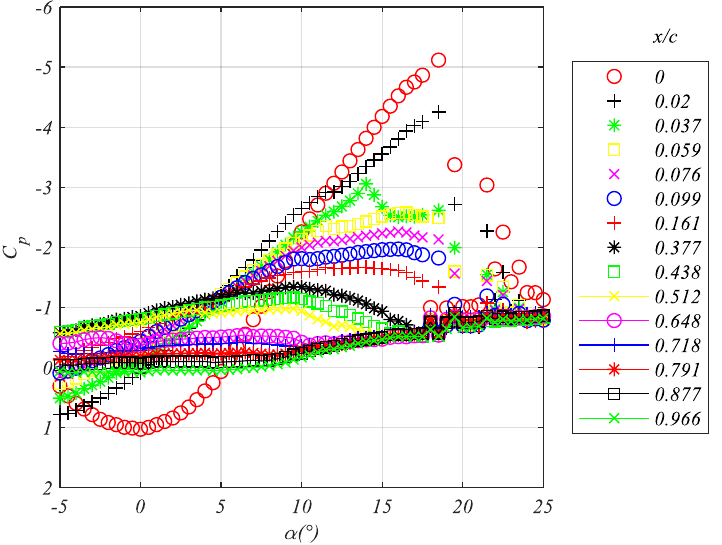
Figure 9. Steady case, Re = 0.5 × 10 6 . Pressure at various × locations versus angle of attack.